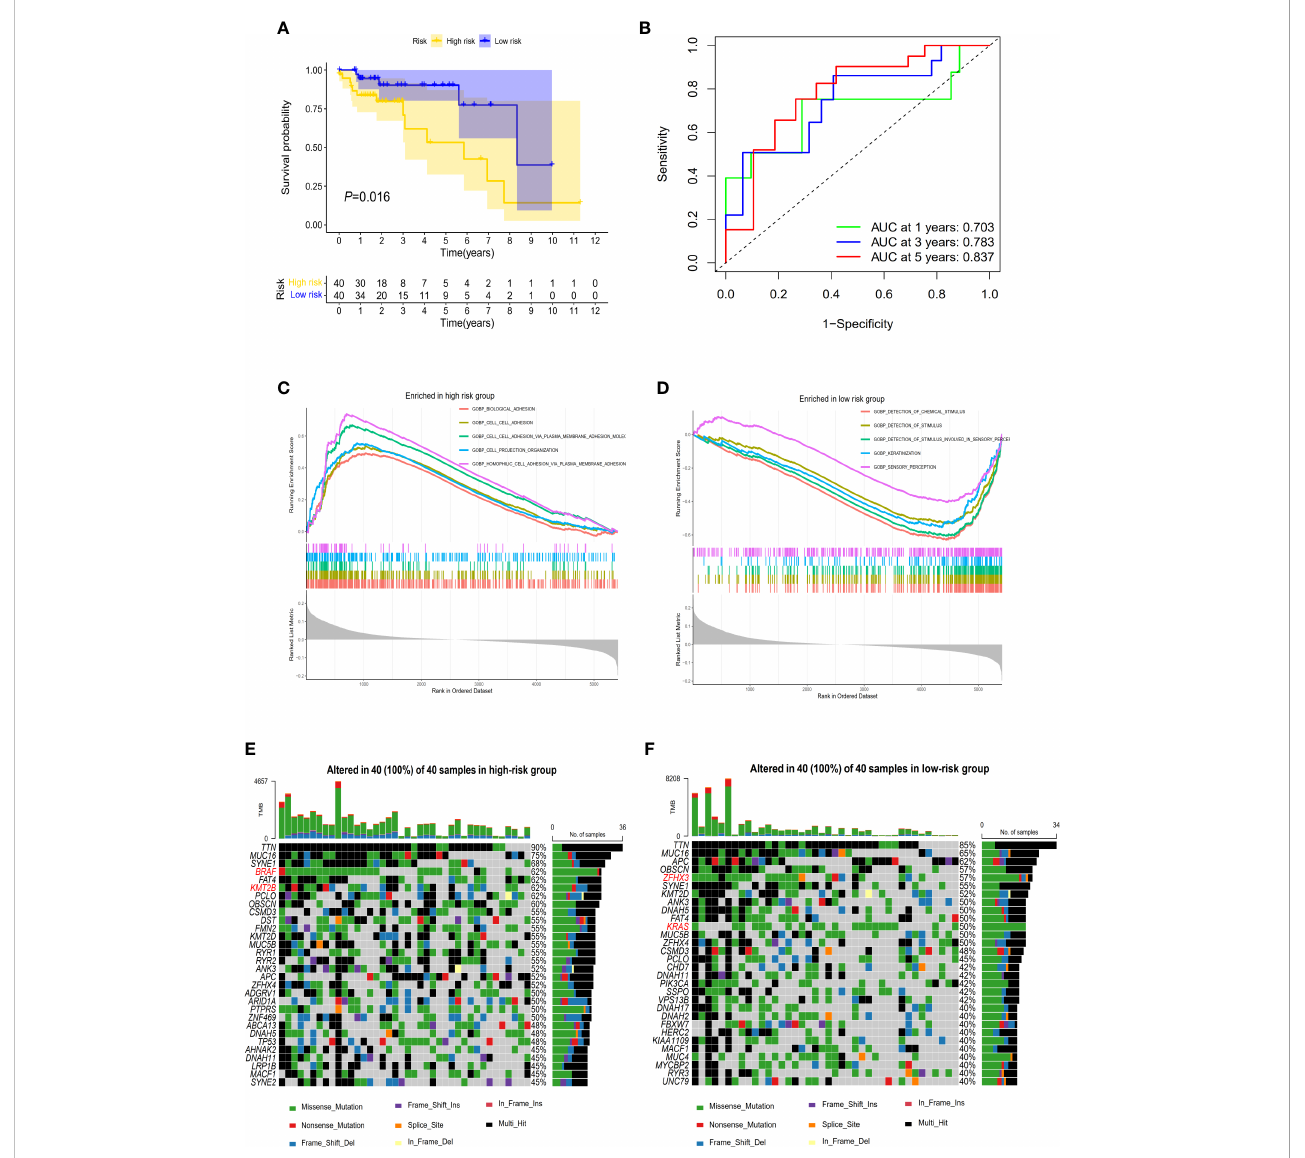
FIGURE 4 The prognostic performance of the 3-gene methylation prognostic score in CRC patients with high TMB. (A) The Kaplan – Meier survival curve on comparing survival between the high- and low-risk groups in the discovery set. (B) Time-dependent ROC curves analysis for the 1-, 3-, and 5-year survival prediction by prognostic model. (C) Gene sets enriched in the high-risk subgroup ( P < 0.05, FDR < 0.25). (D) Gene sets enriched in the low-risk subgroup ( P < 0.05, FDR < 0.25). The waterfall plot of tumor somatic mutation established by those in the high-risk group (E) and the low-risk group (F) . Mutated genes (rows top 30) are ordered by mutation rate. Each column represents individual patients. The right bar plot shows the proportion of each variant